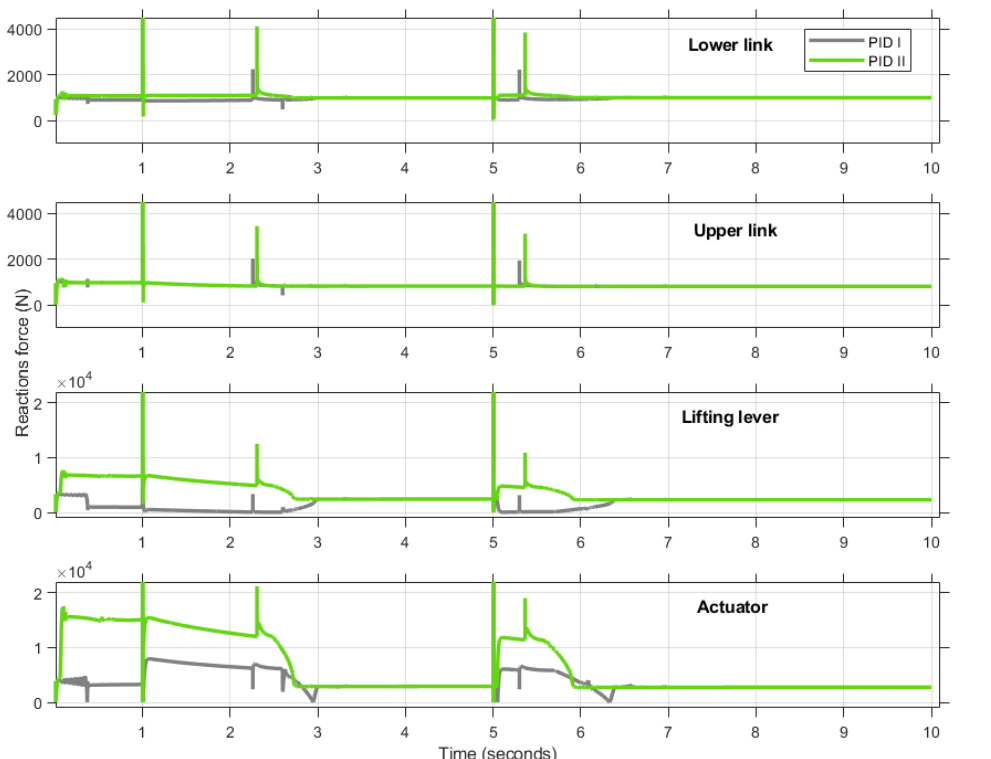
Figure 7. Correlation of reaction forces calculated with various PID.